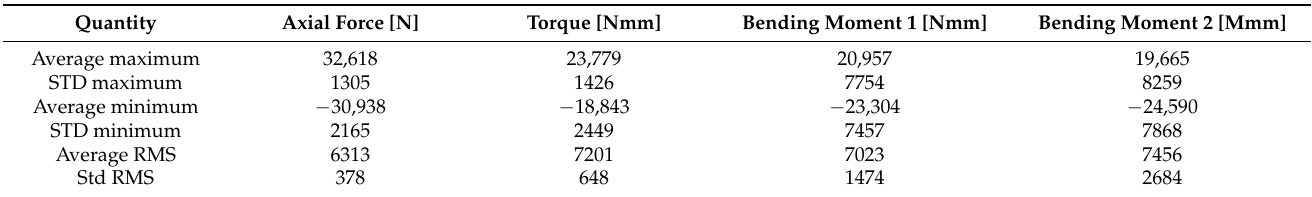
Figure 8. Time zoom of the measured force and torques, test IDN 020. Table 4. Averages and standard deviations (STDs) of maximum, minimum, and RMS values of 100 blows in test IDN 020.